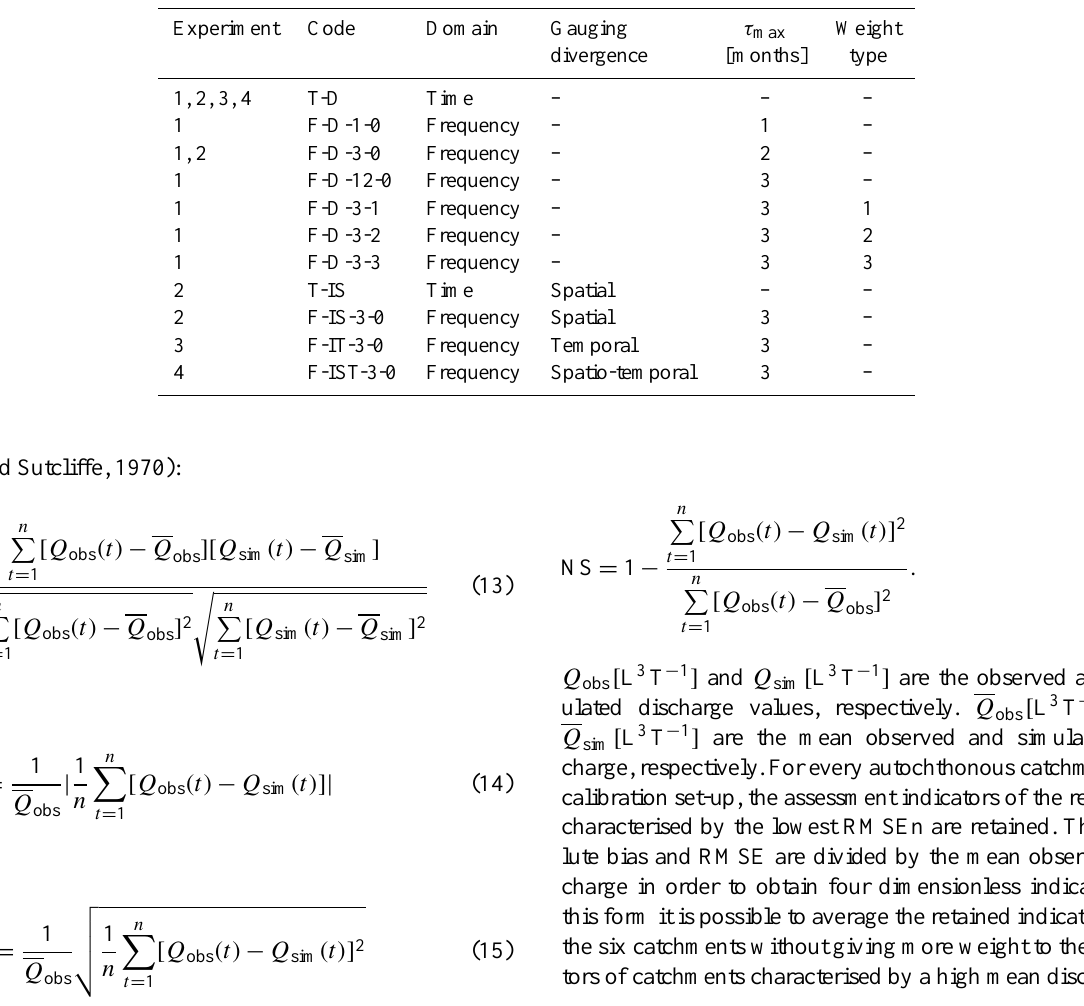
Fig. 4. Actual (solid line) vs. estimated (dashed line) root squared density spectrum ( k > 0) of the discharge time series for the six au- tochthonous catchments in the case of spatial gauging divergence (period 2006–2009). The estimates are rescaled root squared densities of the donor discharge time series. Table 4. Overview of the applied calibration